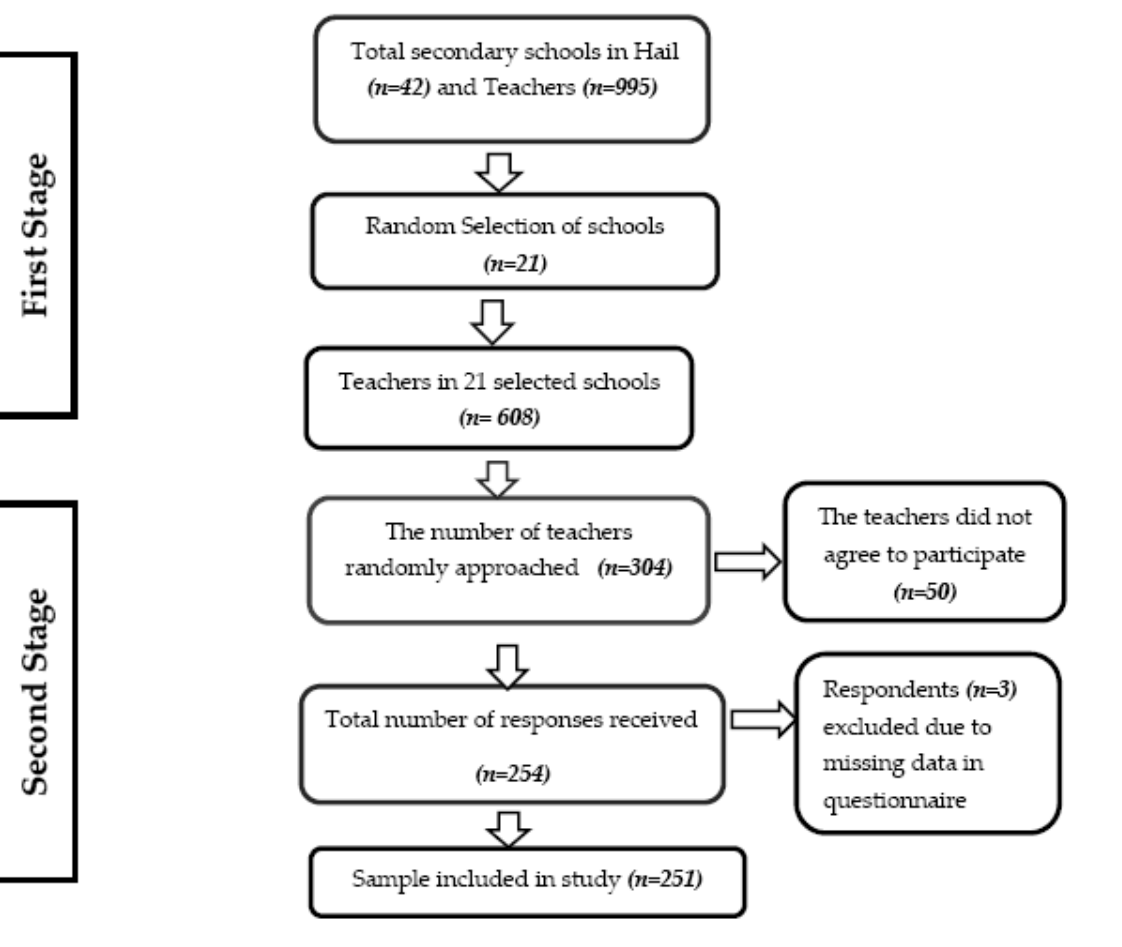
Figure 1. Flow diagram of sample selection .